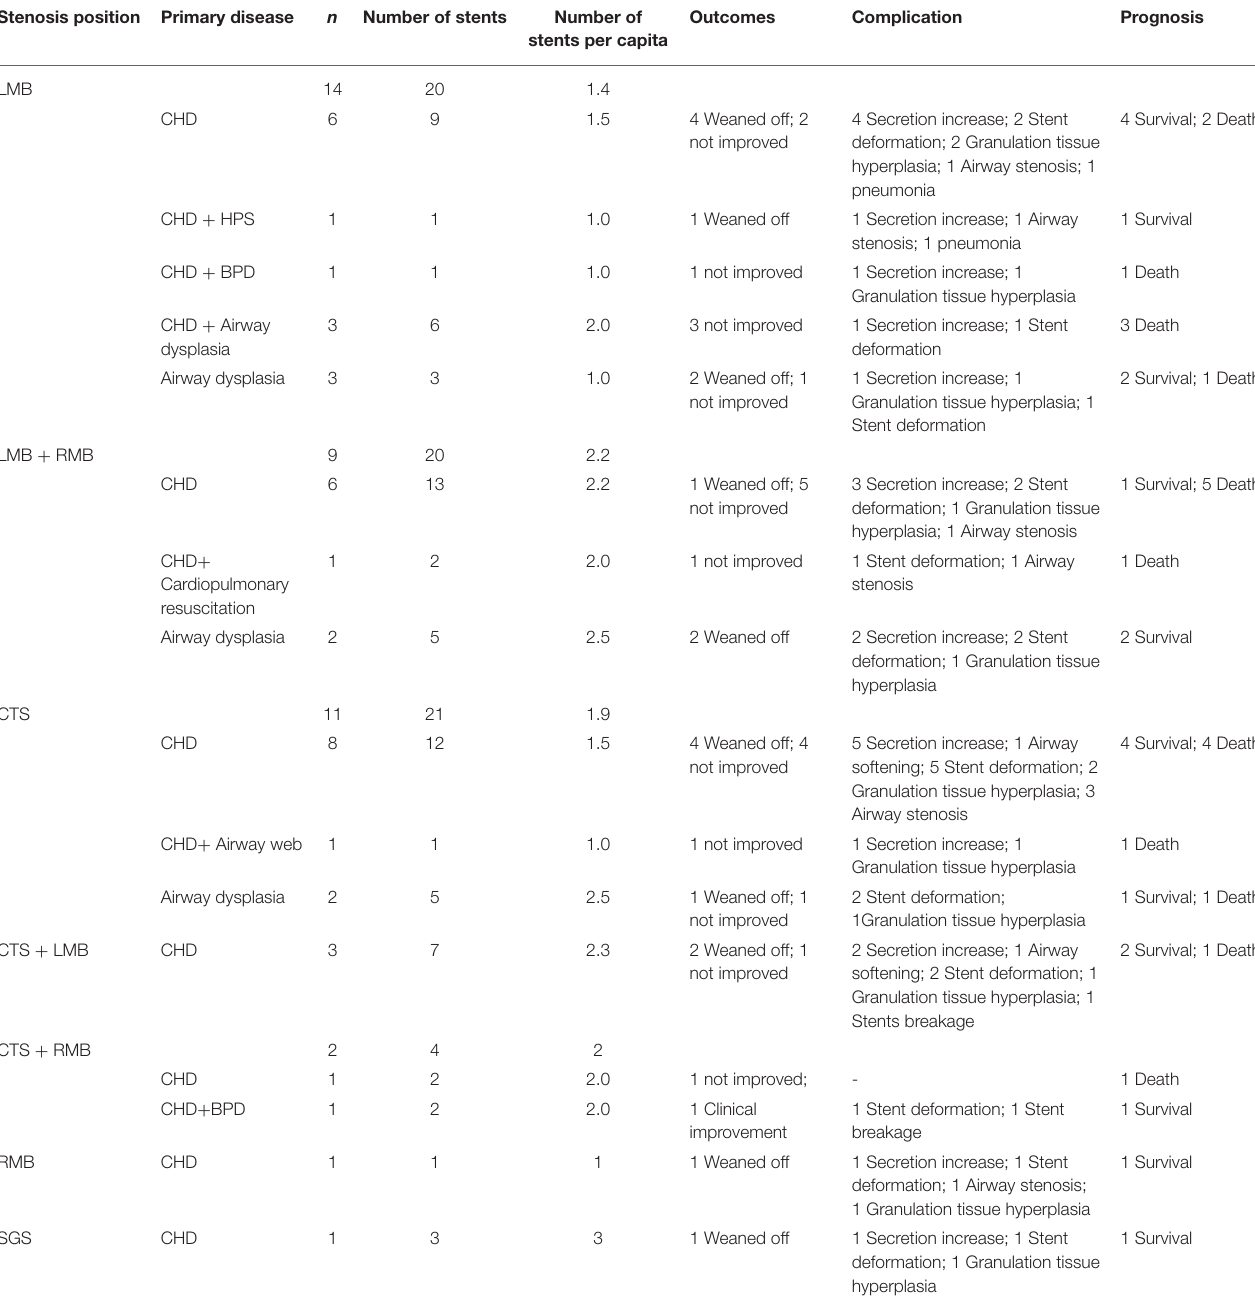
TABLE 5 | Stenosis details, primary disease, outcomes, complication, and prognosis in 41 children with congenital tracheal stenosis. Stenosis position Primary